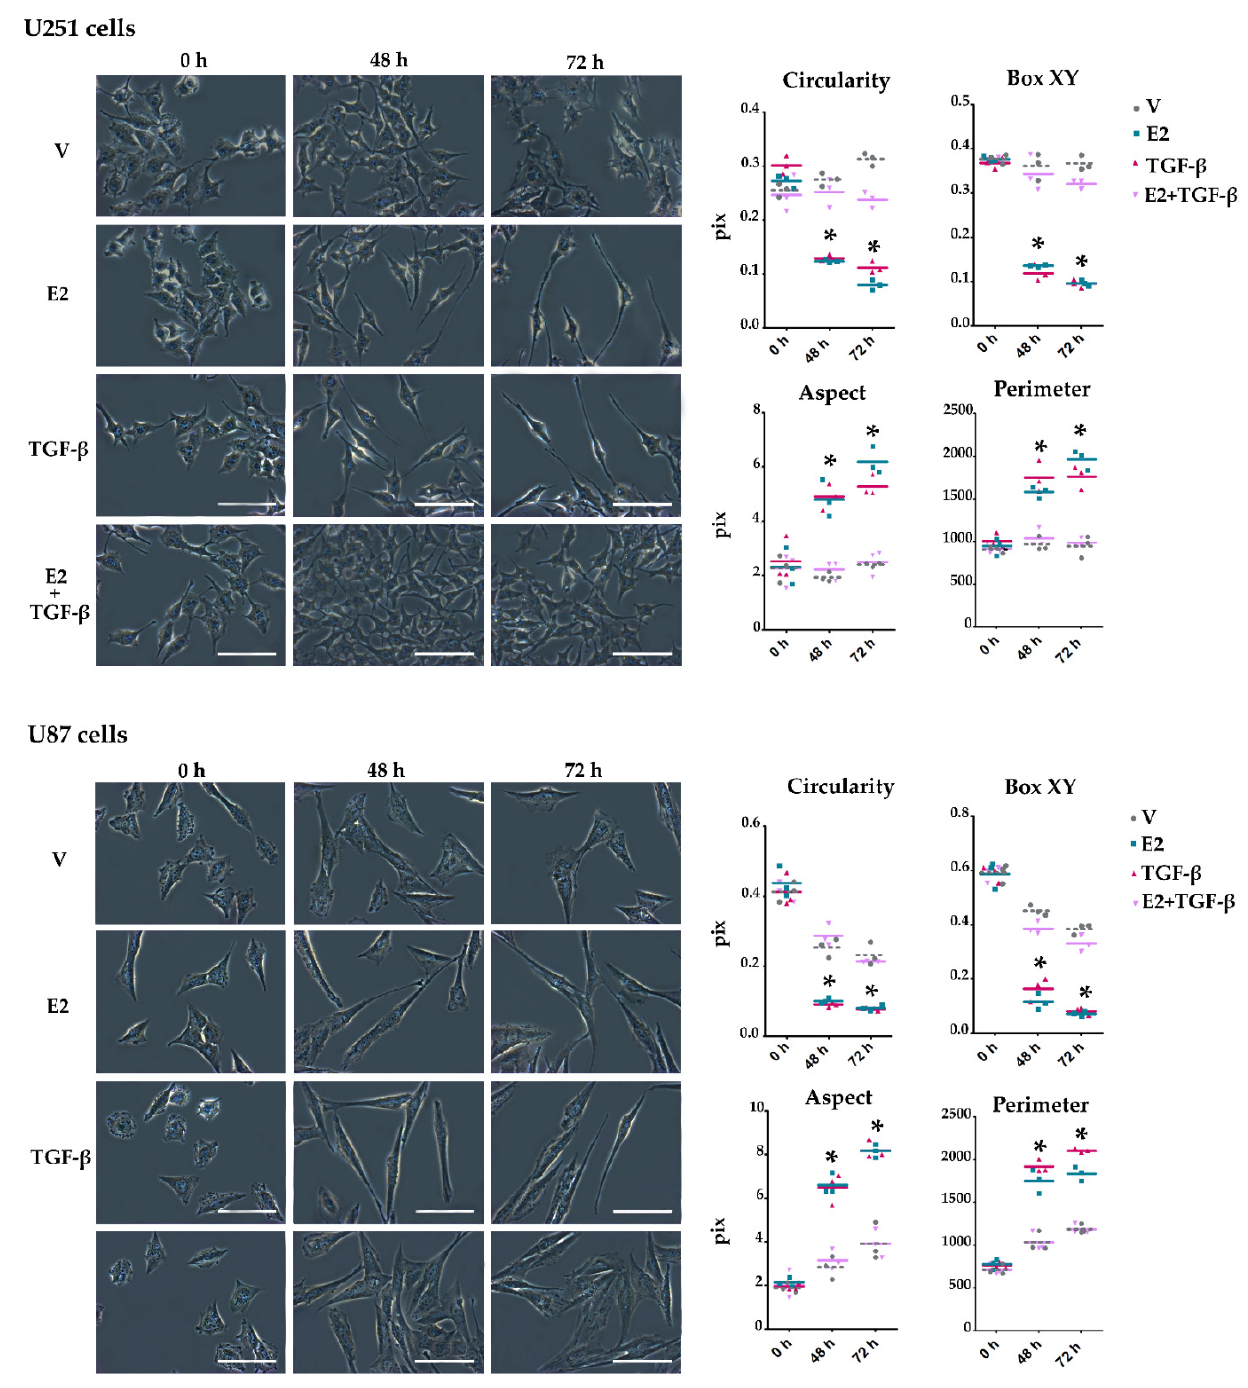
Figure 4. E2 and TGF- β -induced morphological changes in human GBM-derived cells. Representative images of U251 and U87 cells observed by phase-contrast microscopy at 0, 48, and 72 h after adding vehicle (V, 0.01% cyclodextrin + 0.0001% BSA), E2 (10 nM), TGF- β (10 ng/mL) and E2 + TGF- β . Scale white bars = 100 µm. Plots quantized geometric parameters in this study: circularity, box XY, aspect, and perimeter. Results are expressed as the mean ± standard error of the mean (SEM); n = 3; * p < 0.05 vs. V and E2 + TGF- β